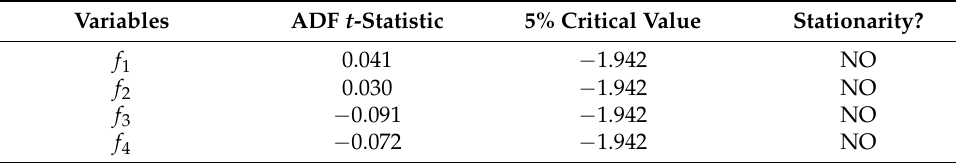
Table 2. ADF test results for the four natural frequencies